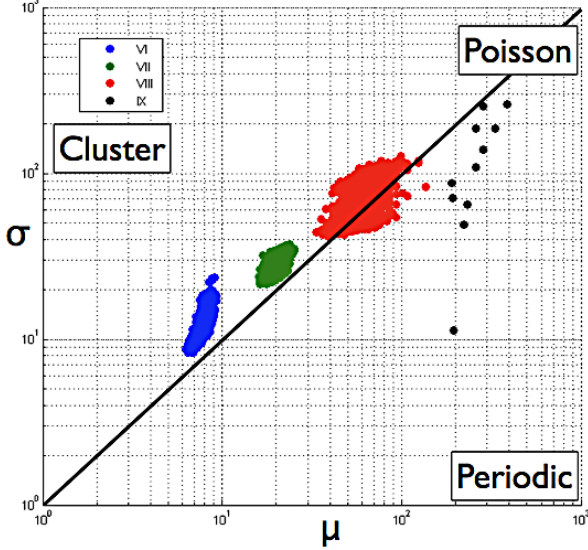
Figure 6. Aperiodicity and clustering for 2000 runs of modified historical catalogues of the Po